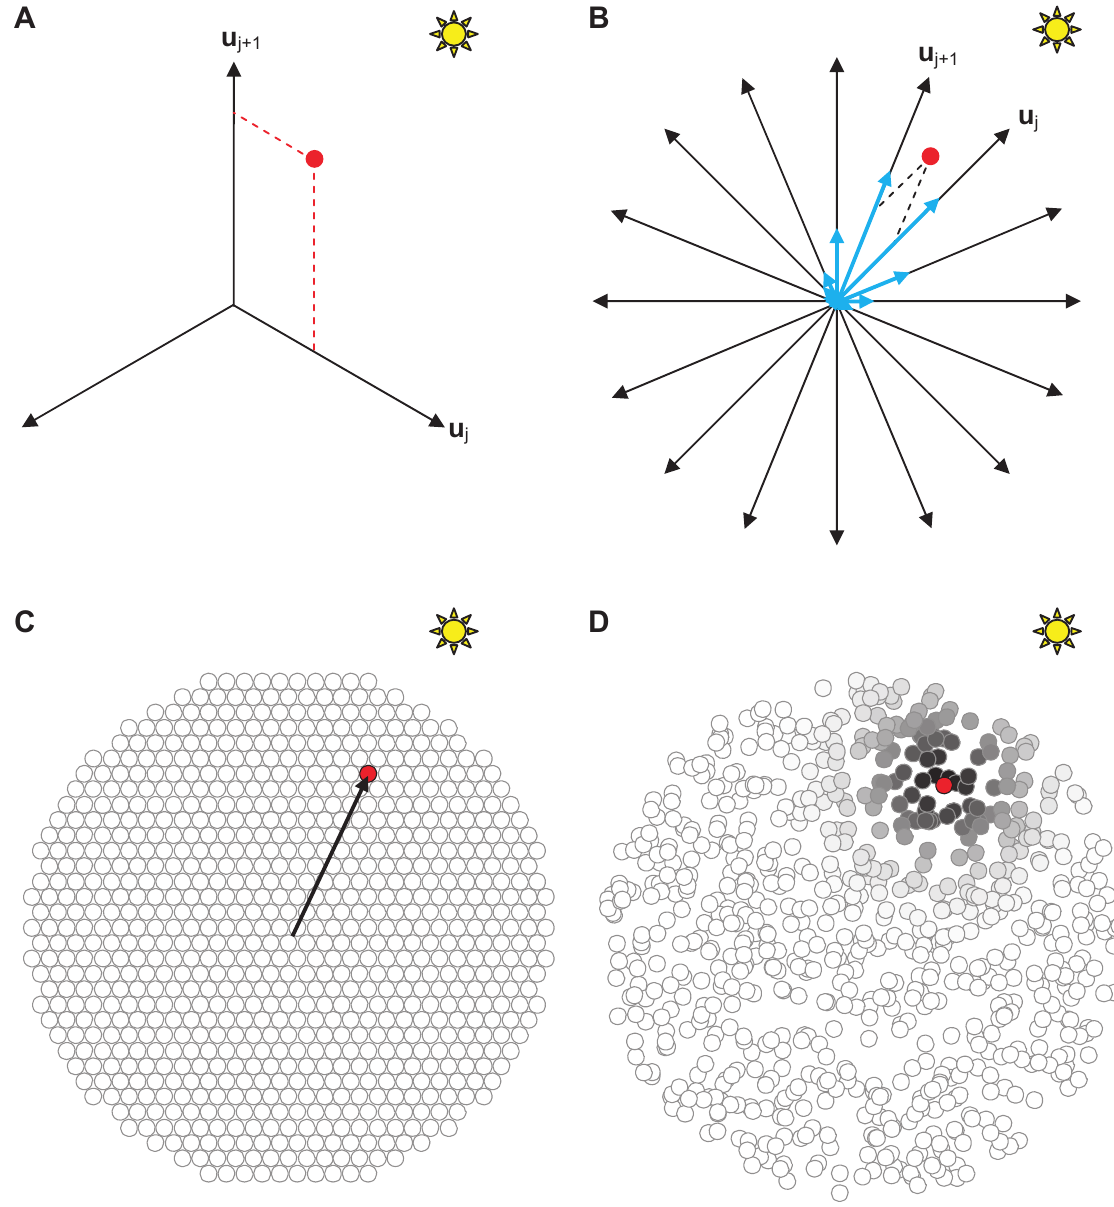
Figure 5. Theoretical variants of the allocentric static vectorial representation (ASVR) of 2-D Euclidean space. ( A ) is an ASVR example with 3 static vectors of dynamic moduli. A position (red dot) may be represented exactly by two scalar values (red dotted line projections) on the bounding static vectors u j and u j + 1 (see Text S2 for further details). ( B ) is an ASVR example with 16 static vectors of dynamic moduli. The scalar coordinates projected on adjacent basis vectors are shown as per (A). An approximate representation is also shown (blue arrows) where a position (or displacement) has a distributed representation. ( C ) shows a graphical example consisting of static vectors (ends shown as circles) with static moduli, distributed in a closest packing arrangement. Each position (e.g. red dot) is designated by one particular static vector with a binary response to indicate the navigating agent’s presence or absence at that position. Note that the start location during PI is arbitrary from a computational perspective, but once set (e.g. start of arrow) it is expected to remain stable for at least the duration of the current journey. ( D ) shows a graphical example consisting of static vectors with static moduli, distributed randomly. Here the greyscale shading indicates a graded response which may be inversely related to the proximity of the agent’s position (red dot) to each static vector’s optimally tuned position, or be a likelihood estimate of the agent being at any particular position.